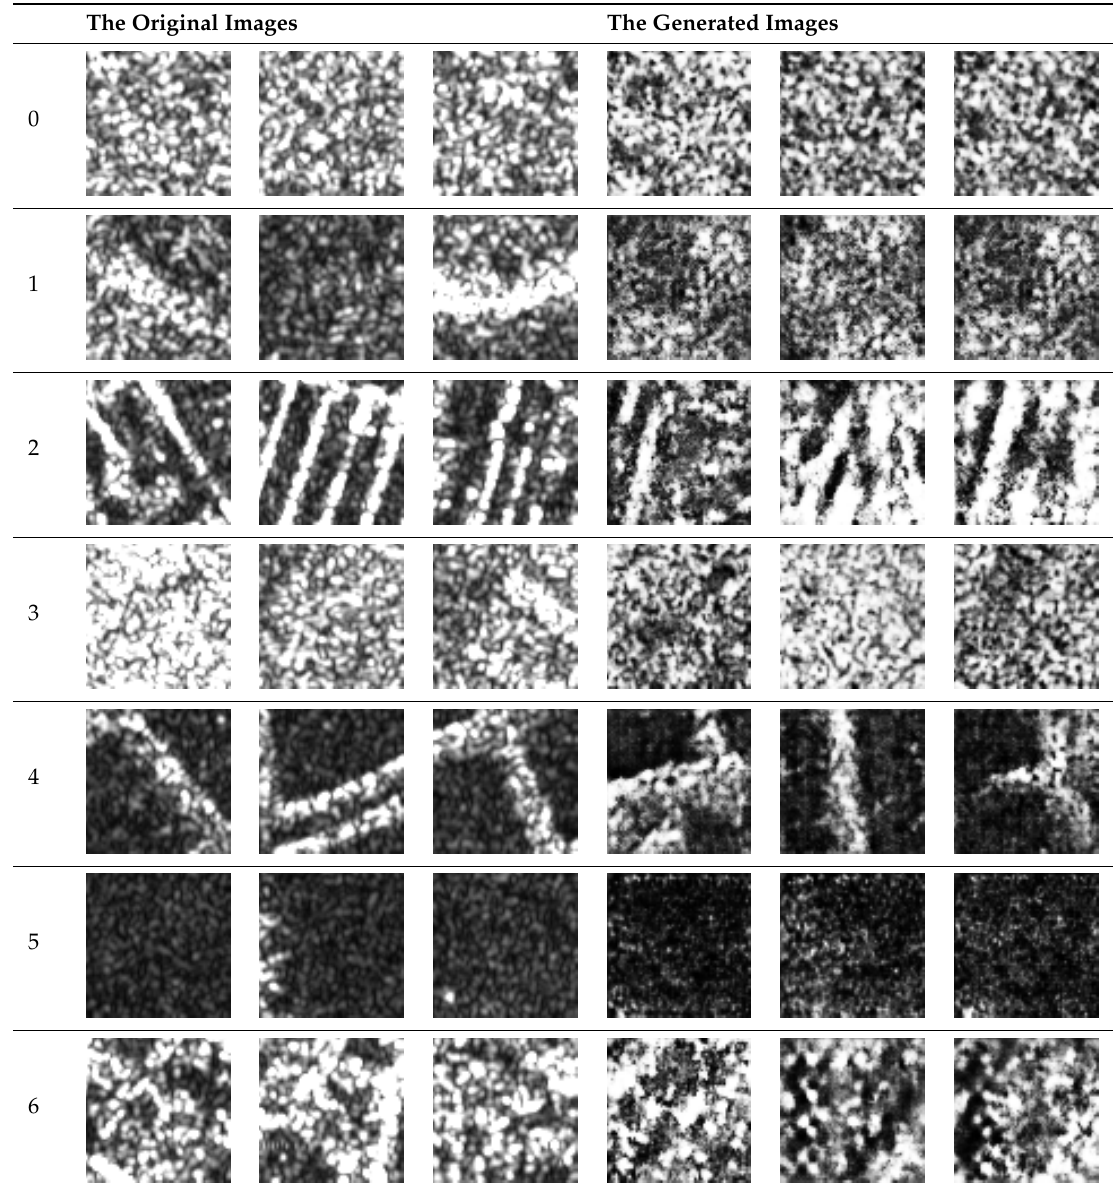
Table 3. DataSet1: The original images and the images generated by